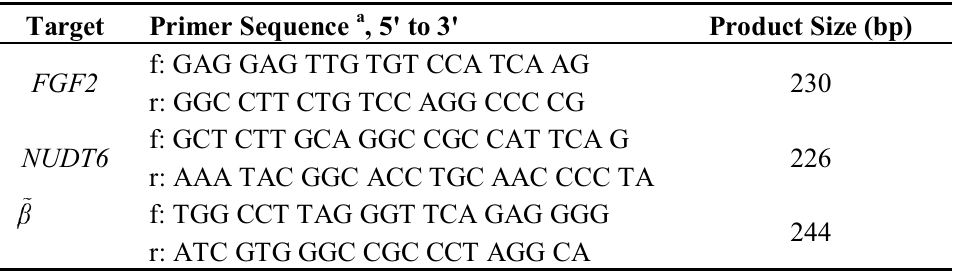
Table 1. Primers used for PCR